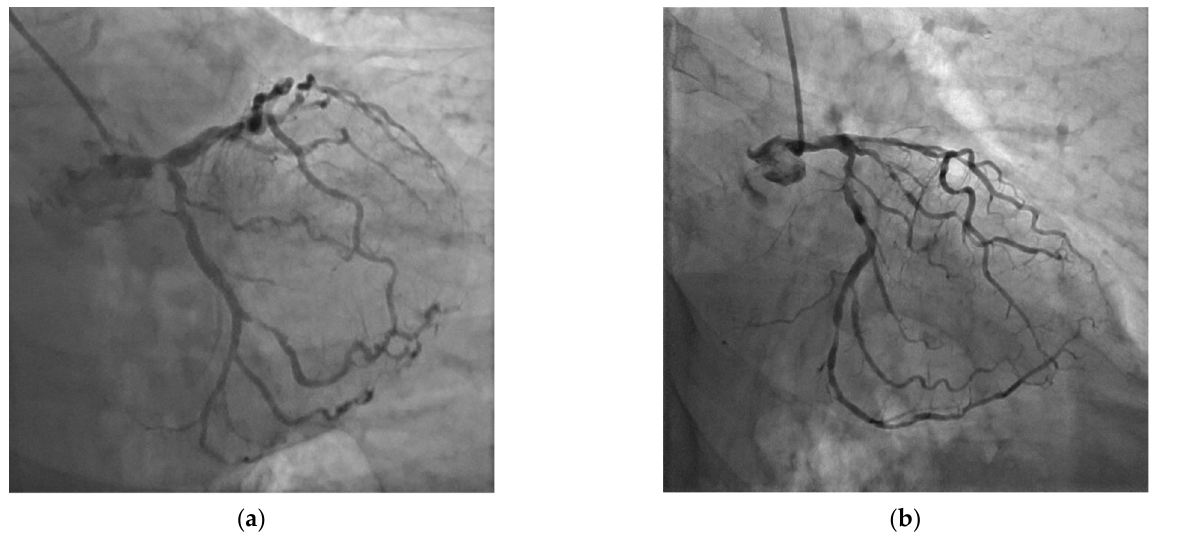
Figure 1. Coronary angiograms. ( a ) Severe distal left main coronary artery (LMCA) lesion. ( b ) Dis- seminated coronary artery disease with shaft LMCA lesion.